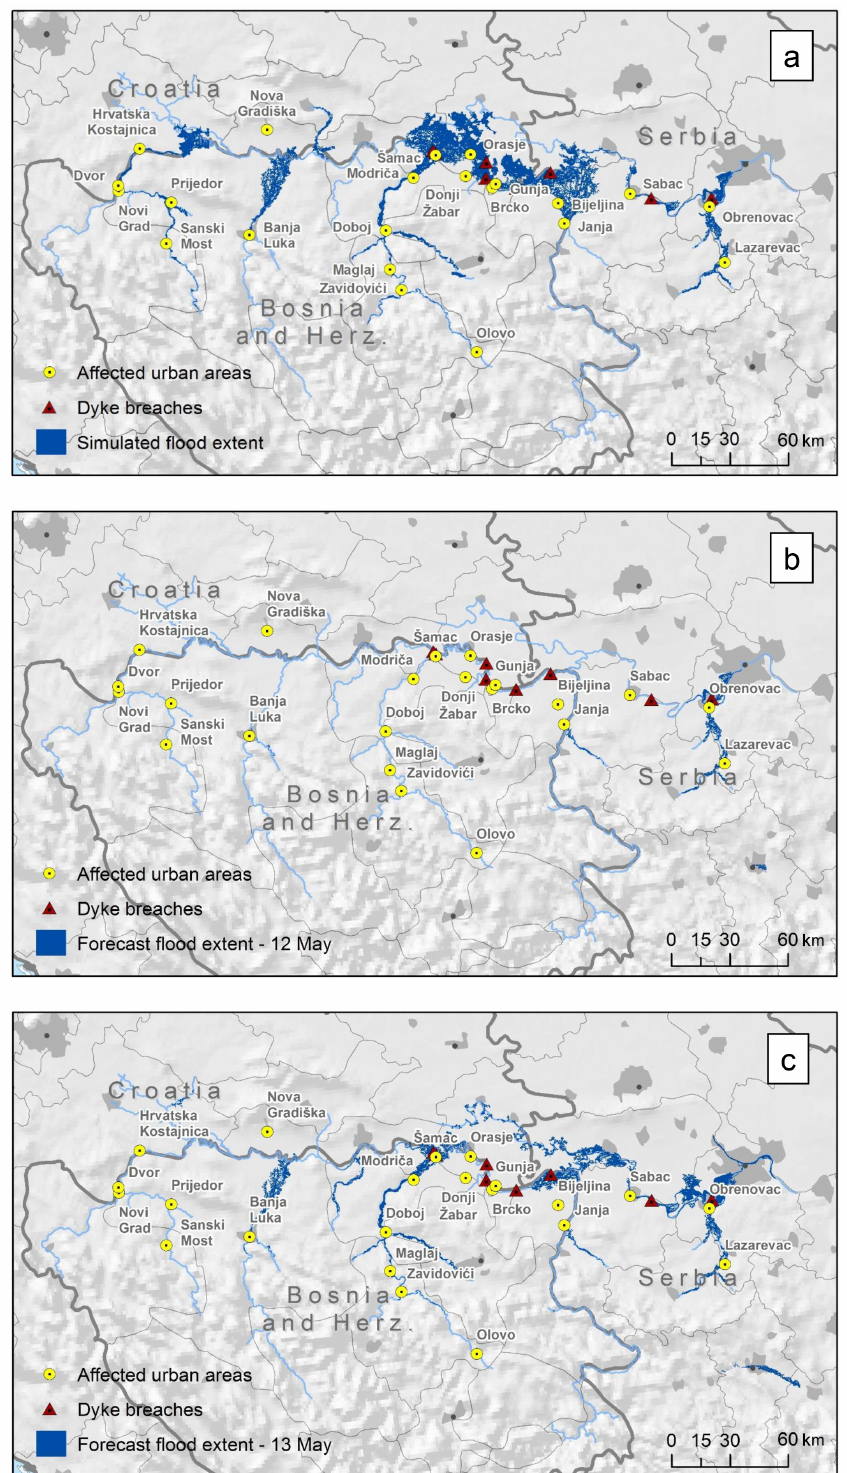
Figure 5. (a) Simulated flood extent based on reference simulation; (b) 12 May forecast; (c) 13 May forecast. Locations of reported flooded urban areas and dyke failures are also